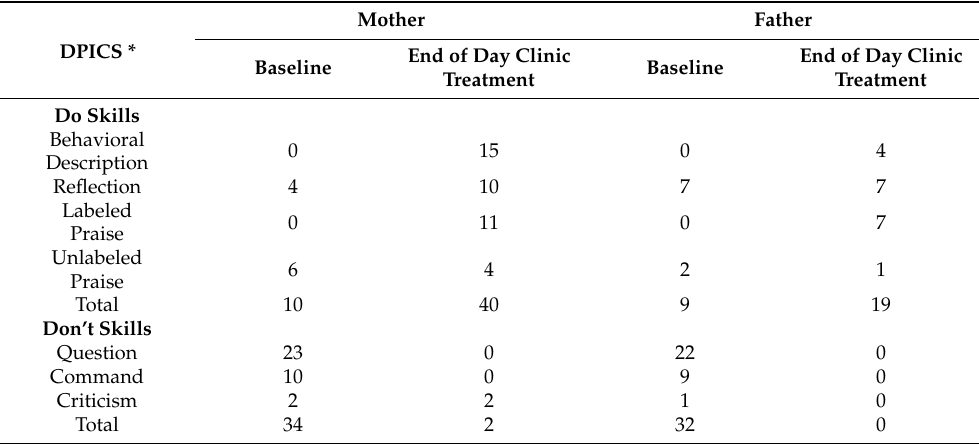
Table 1. Parents’ child-directed interaction (CDI) skills at baseline and at the end of the day clinic